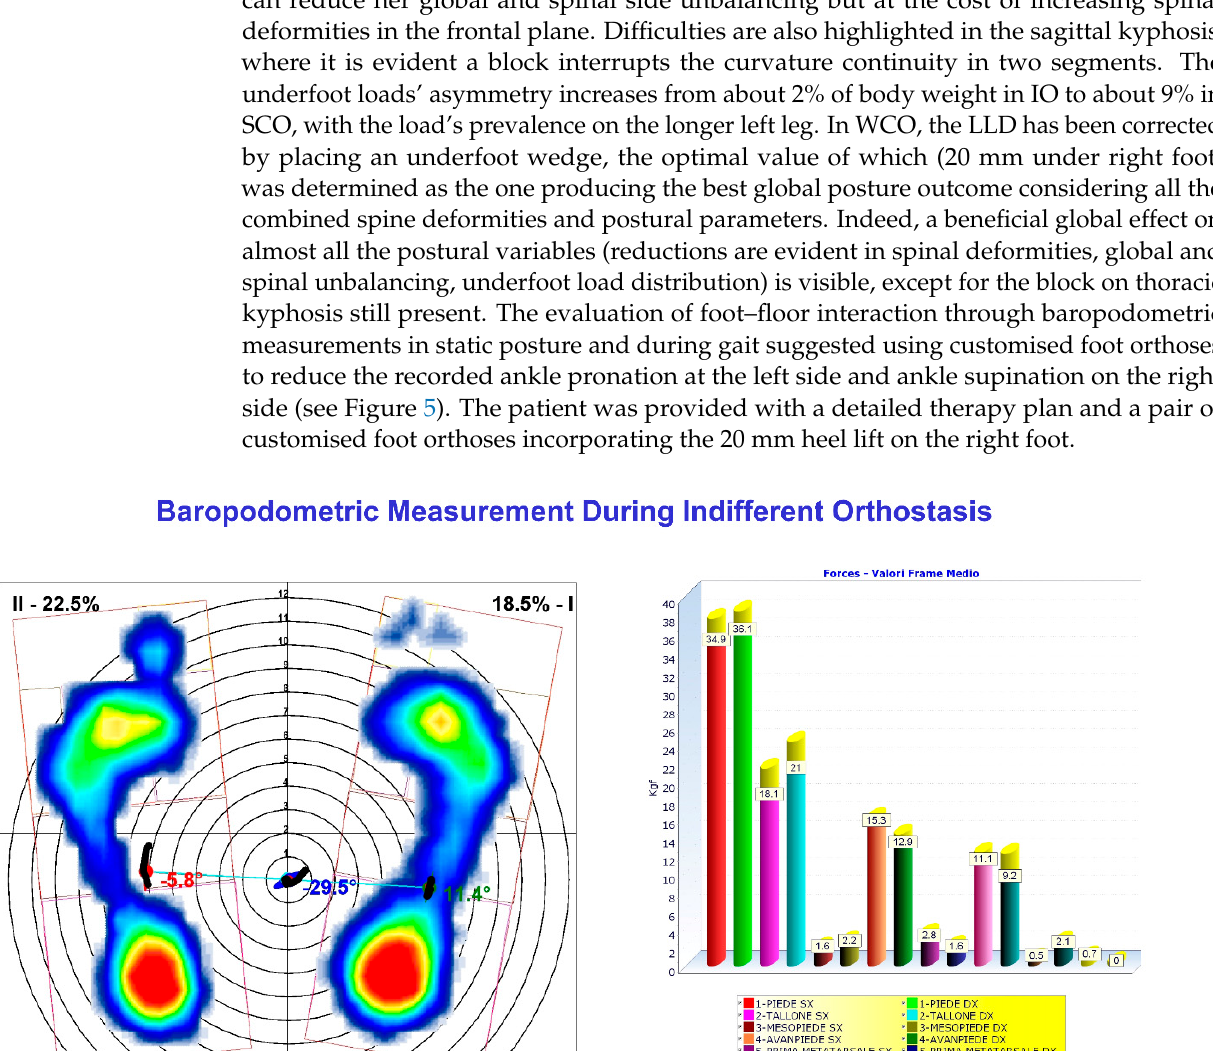
Figure 5. Baropodometric measurement during indifferent orthostasis.